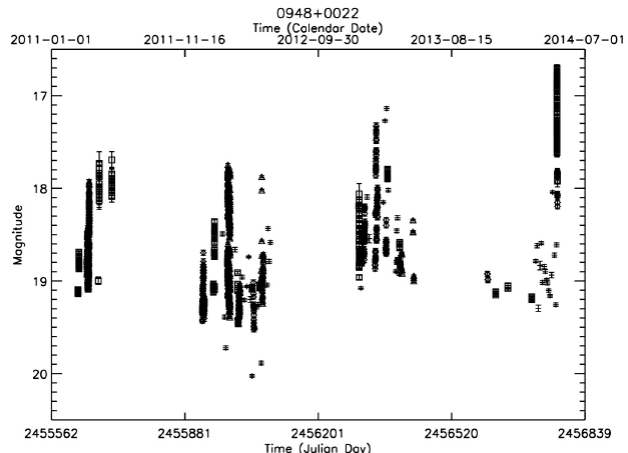
Figure 1. Multi-year light curve of J0948+0022.